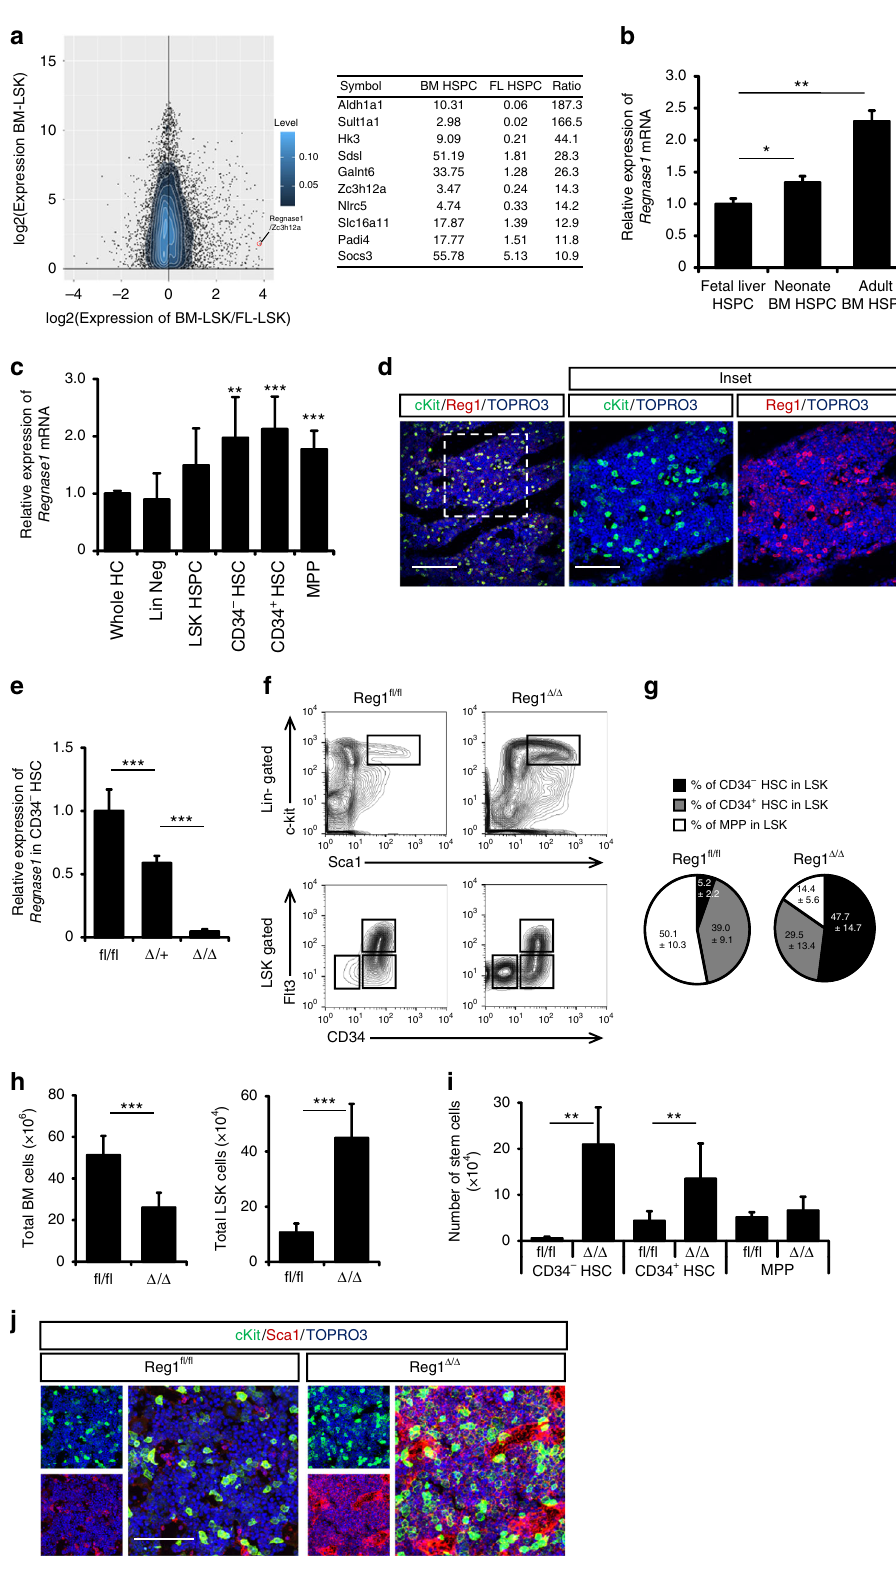
cues from the adult BM microenvironment induce growth arrest pool. Therefore, we investigated when the anomalous increase of of HSCs in the G0 phase of the cell cycle and maintain HSC HSPCs occurs in Regnase-1-de fi cient mice. Flow cytometric quiescence 25 . Because Regnase-1 expression is upregulated in analysis of FL cells from E15.5 embryos and BM cells from 1-day- HSPCs of adult BM compared with those of the fetus, this sug- old neonates revealed no differences in the numbers or propor- gests the involvement of Regnase-1 in the regulation of the HSC tions of HSPCs. However, we found abnormal accumulations of NATURE COMMUNICATIONS| (2019) 10:1072